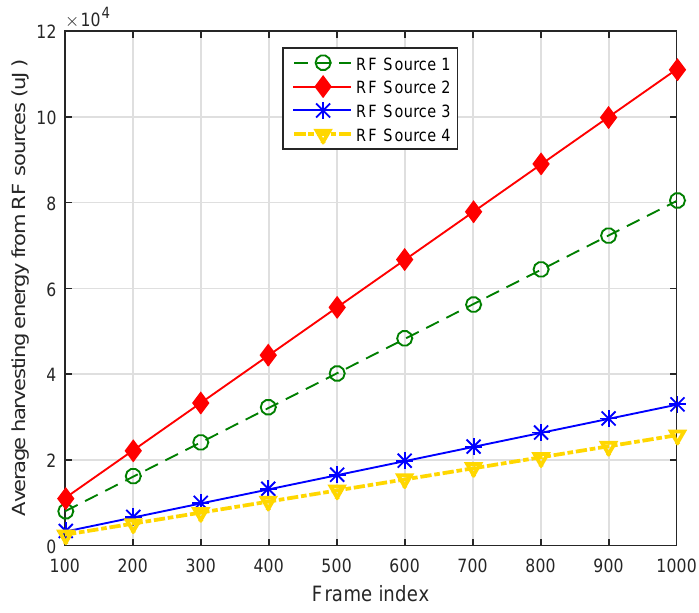
Figure 7. Average harvesting energy from RF sources.